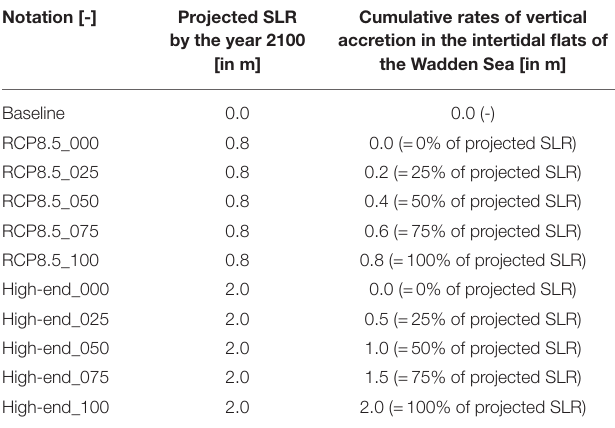
TABLE 1 | Notations of investigated scenarios as well as associated values of SLR and cumulative rates of vertical accretion. Notation [-]